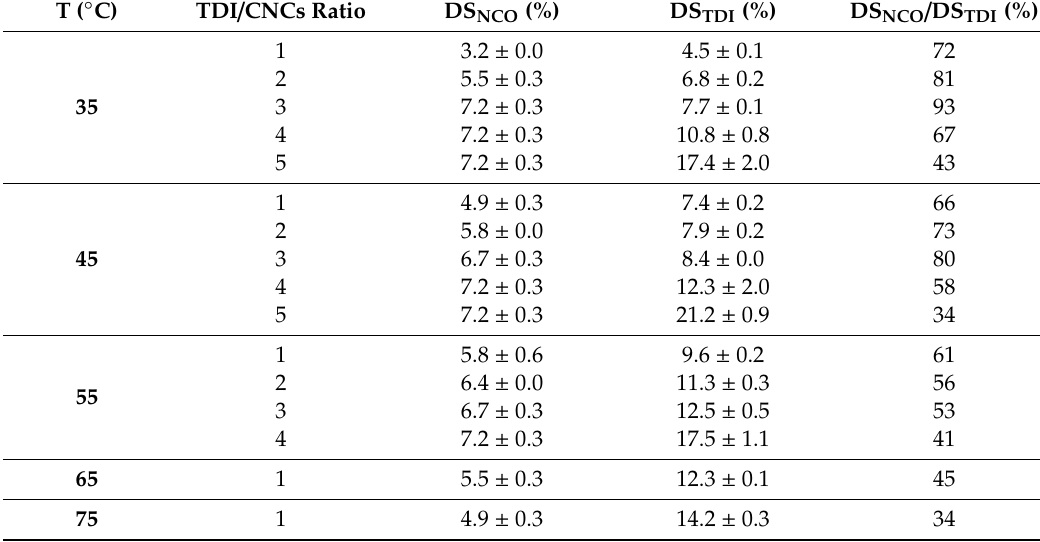
Table 2. The impact of reaction conditions on degree of substitution of isocyanates (DS NCO ), degree of carbamation (DS TDI ), and the e ffi ciency of CNC carbamation. Time and CNC amount were kept constant (24 h and 1.0 g,